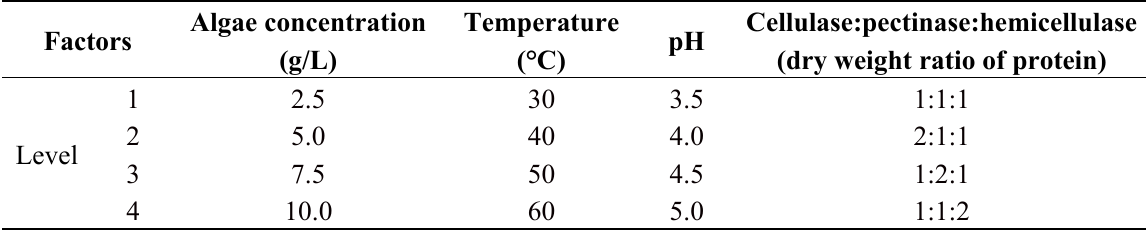
Table 2. Levels and factors of orthogonal experiment for enzymatic